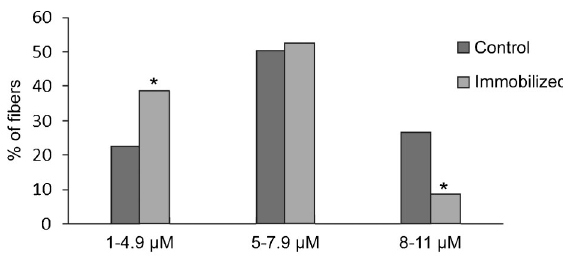
Figure 3. Frequency distributions of sciatic nerve fiber diameters in 101 fibers from control animals and 204 fibers from experi- mental animals. *P , 0.001, compared to control (chi-square